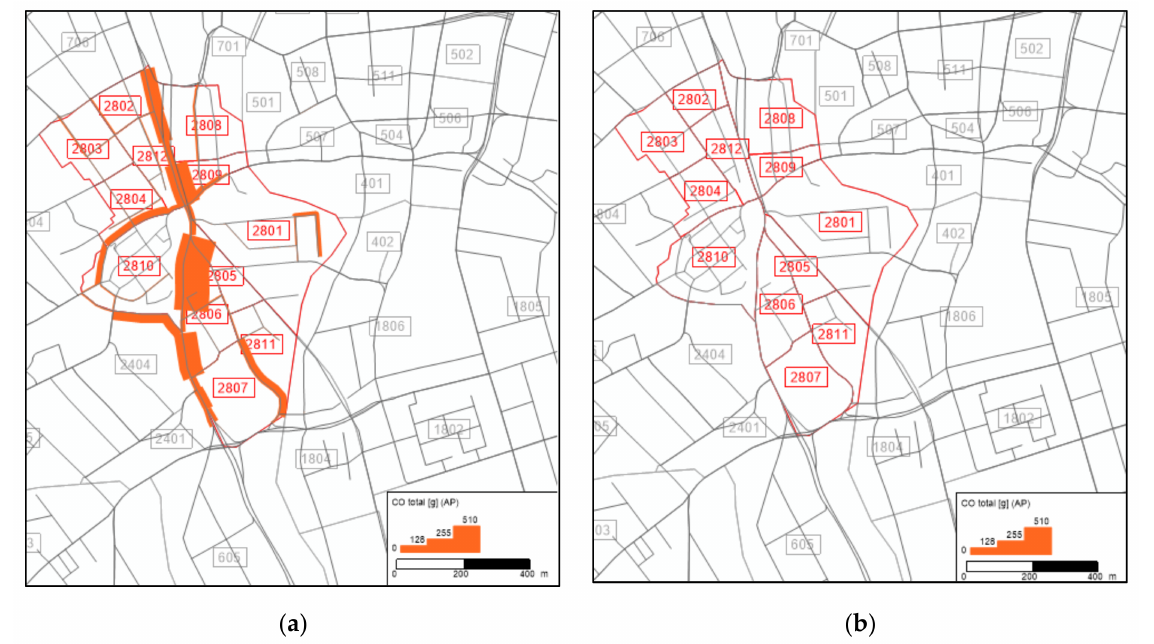
Figure 14. The assessment of CO total [g] (measure from Group 1) for scenario W0 and optimal scenario (W3)—analysis for the central areas of the city: ( a ) measures for scenario W0; ( b ) measures for scenario W3.